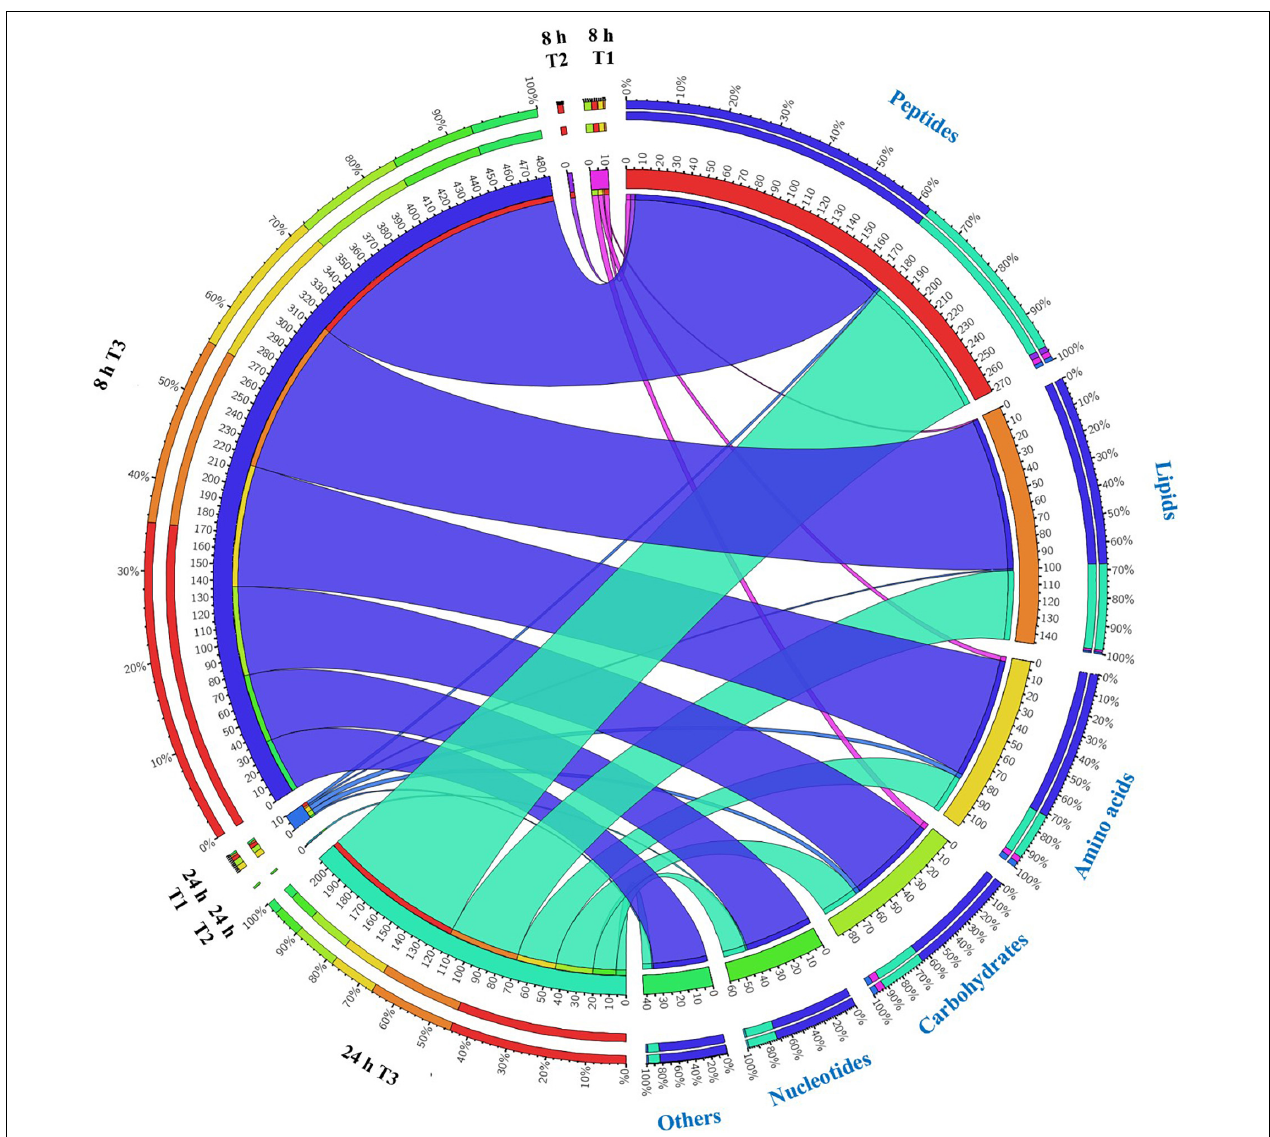
FIGURE 4 | Metabolome response of E. coil at 8 h and 24 h. Bipartite graph exhibits correlations between the number of significant metabolites (left side) and significantly affected metabolites (FDR < 0.05, p < 0.05 and fold change ≥ 2) (right side, the quantity and proportion). The number of metabolites significantly affected by over-expression of pBAD (T1 = pBAD + Arabinose vs. pBAD), pBAD- mcr-1 (T2 = pBAD- mcr-1 vs. pBAD), or over-expression of pBAD- mcr-1 (T3 = pBAD- mcr-1 + Arabinose vs. pBAD +